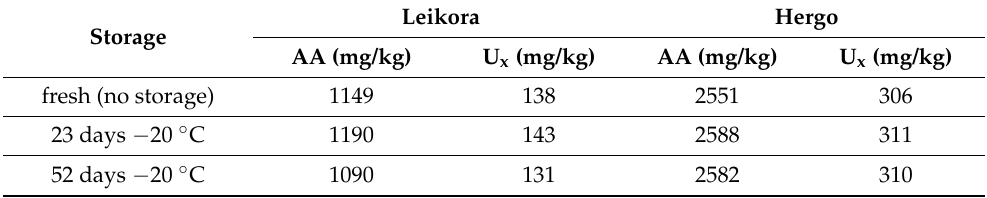
Table 3. Content of ascorbic acid in sea buckthorn fruit stored under freezing conditions. Storage